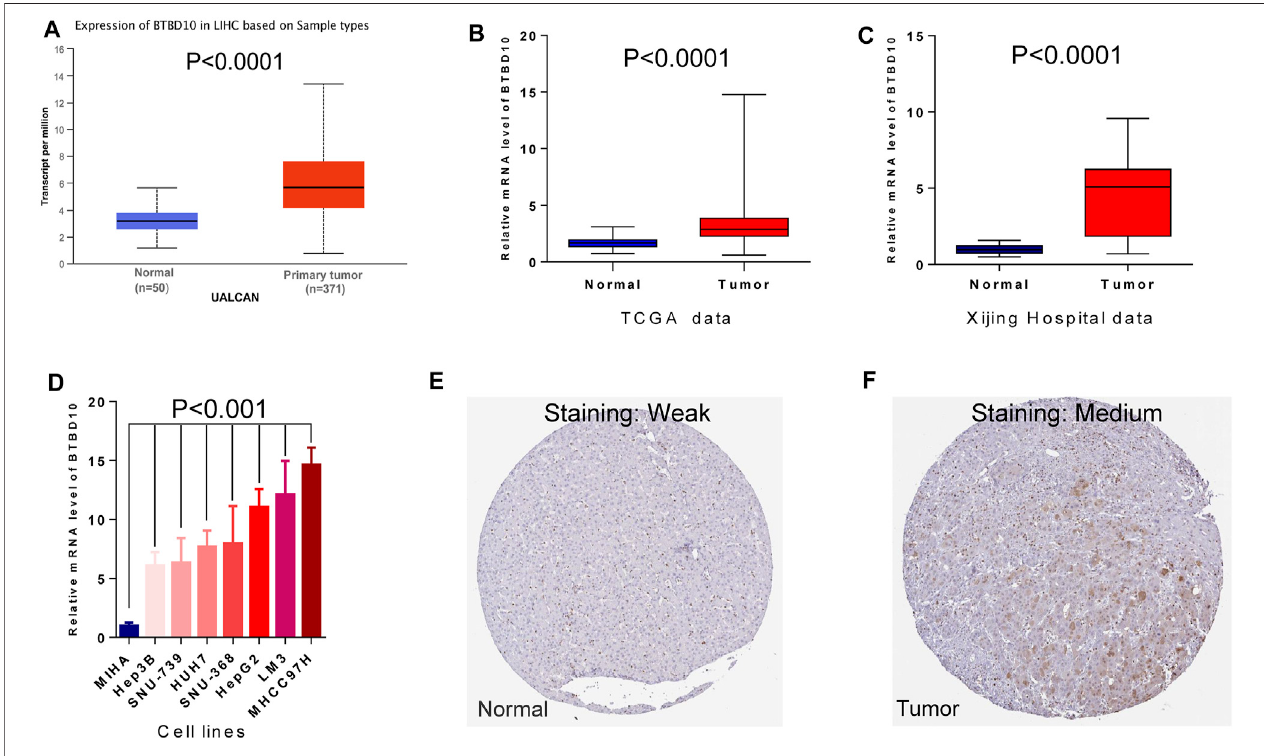
FIGURE 2 | Differences in expression of BTBD10: (A) UALCAN data; (B) TCGA data; (C) Xijing Hospital data; (D) cell lines. Representative images of immunohistochemical staining for BTBD10 in normal liver tissues and HCC tissues from the Human Protein Atlas: (E) normal tissues; (F) tumor tissues.